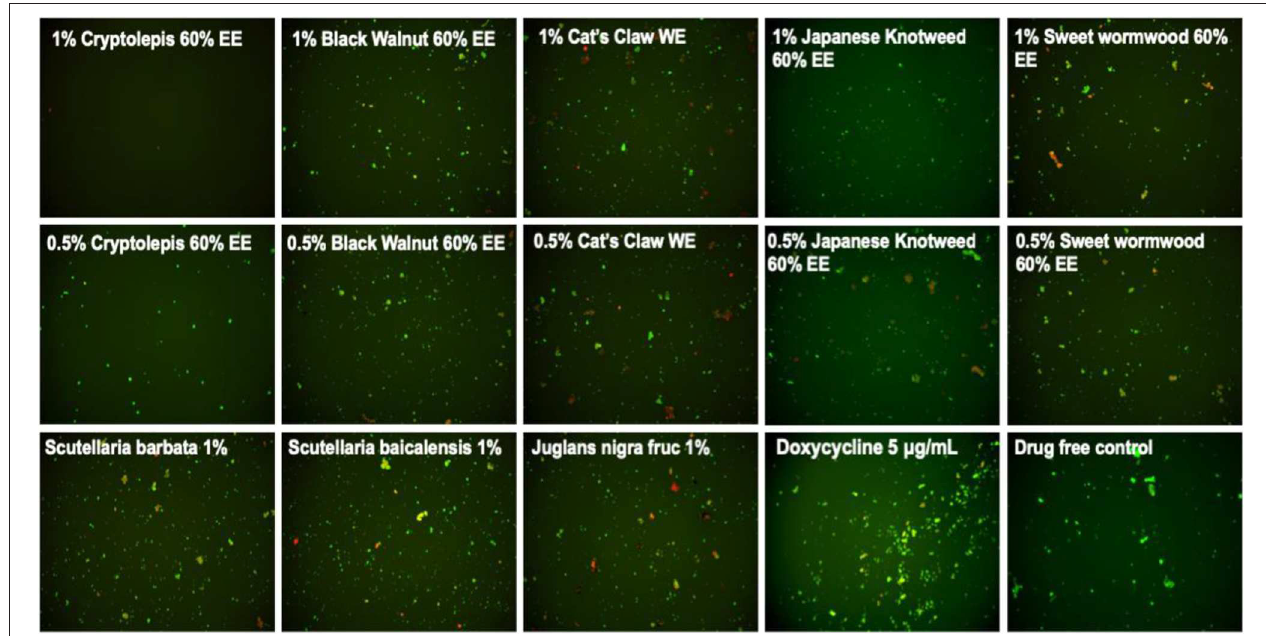
FIGURE 2 | Subculture of Borrelia burgdorferi after treatment with natural product extracts. A 7-day stationary phase B. burgdorferi culture was treated with the indicated natural product extracts for 7 days followed by washing and resuspension in fresh BSK-H medium and subculture for 21 days. The viability of the subculture was examined by SYBR Green I/PI stain and fluorescence